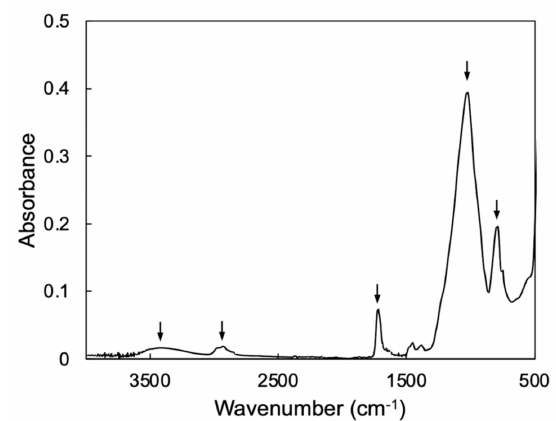
Figure 1. FT-IR spectrum of the SiO 2 /pHEMA-based composite. The arrows in the figure show the composite